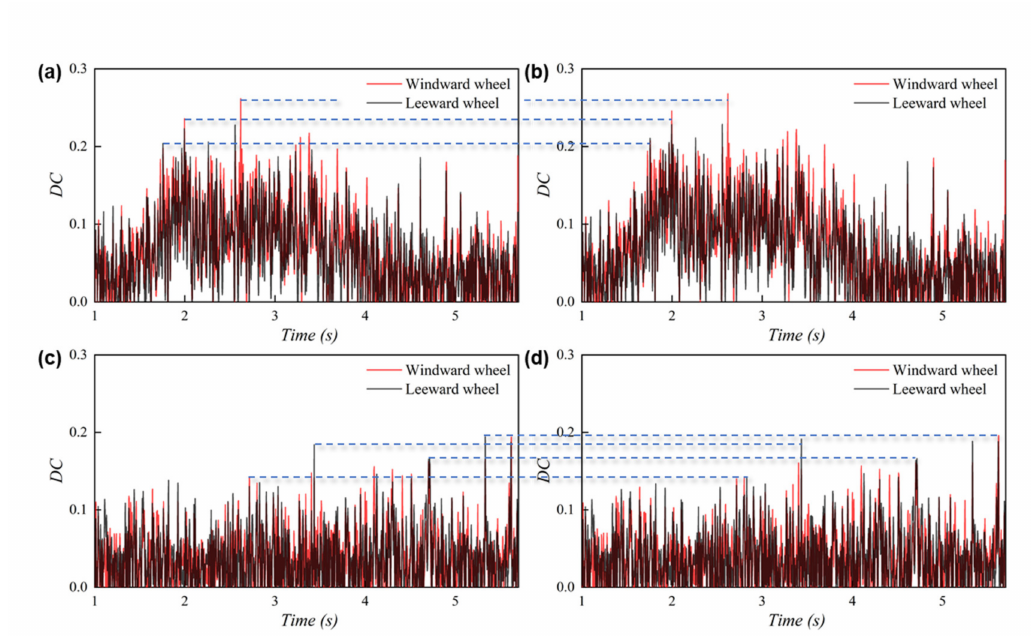
Figure 14. Time-varying DC values of two wheelsets: ( a ) the first wheelset of the leading car without posture; ( b ) the first wheelset of the leading car with posture; ( c ) the last wheelset of the trailing car without posture; ( d ) the last wheelset of the trailing car without